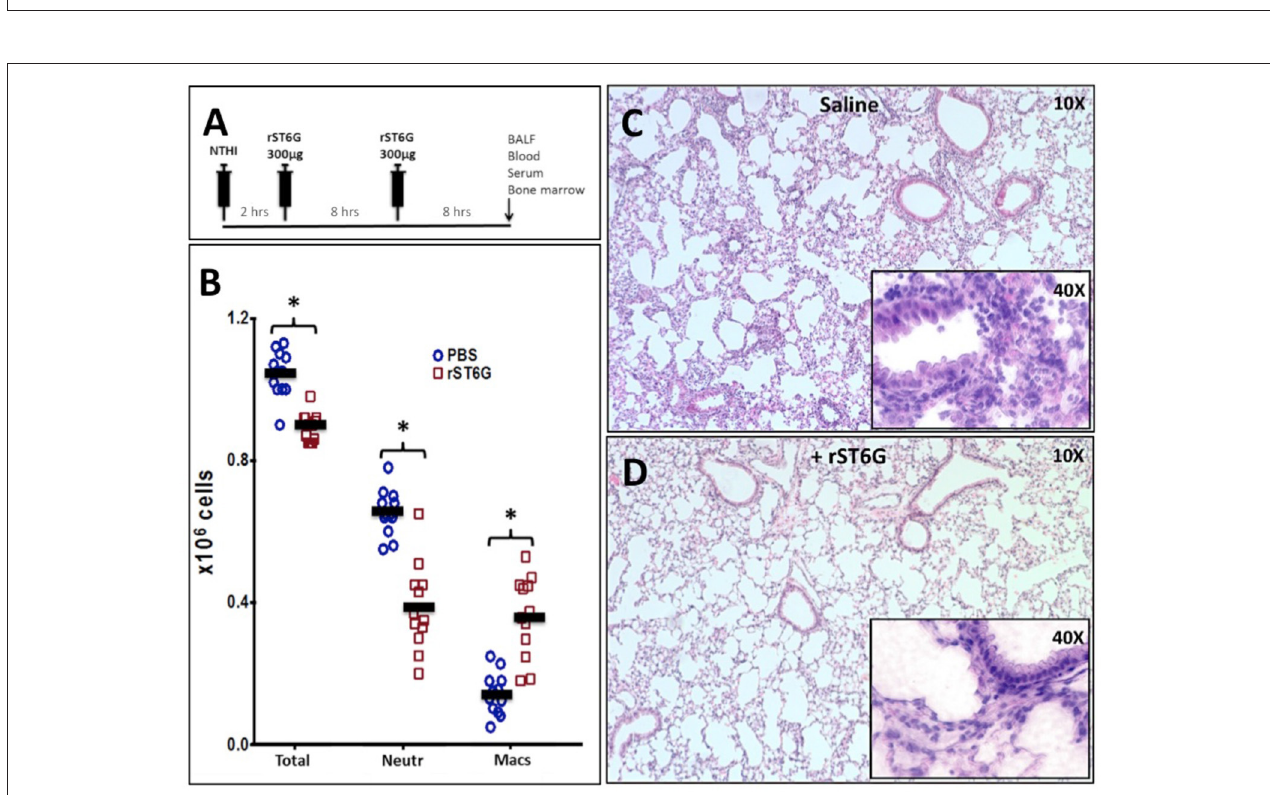
FIGURE 4 | Acute airway inflammation induced by NTHI exposure is mitigated by rST6G infusion. (A) shows the intervention protocol where each animal received two 300 µ g rST6G or saline/sham injections spaced 8h apart with the first injection being at 2h after NTHI challenge. Animals were sacrificed 18h later and assessed for pulmonary inflammation. (B) Inflammatory cell accumulation in the BALF of the rST6G- and sham- (PBS) treated animals showing total BALF cells (Total), neutrophil (Neutr), and macrophage accumulation (Macs). * p < 0.01. (C,D) Show the lung pathology of saline and rST6G-treated animals, respectively at 18h.